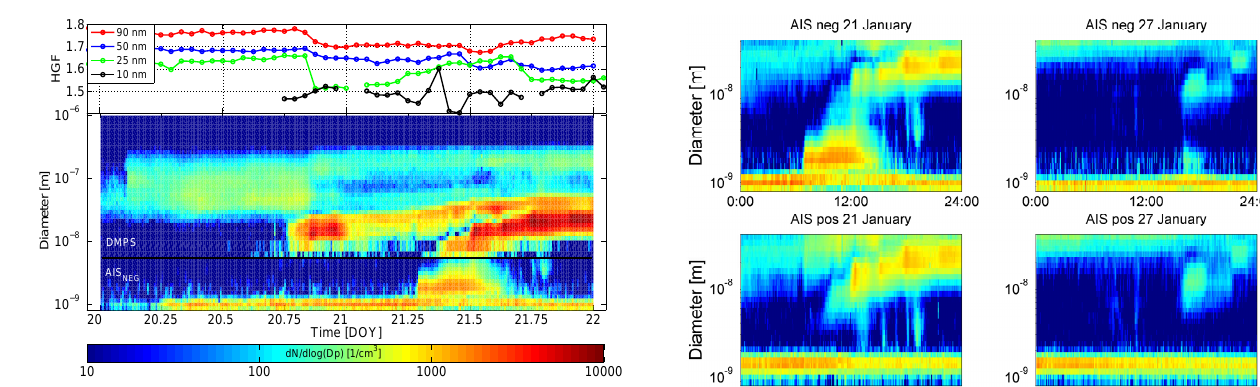
presented by Kerminen and Kulmala (2002). Using values